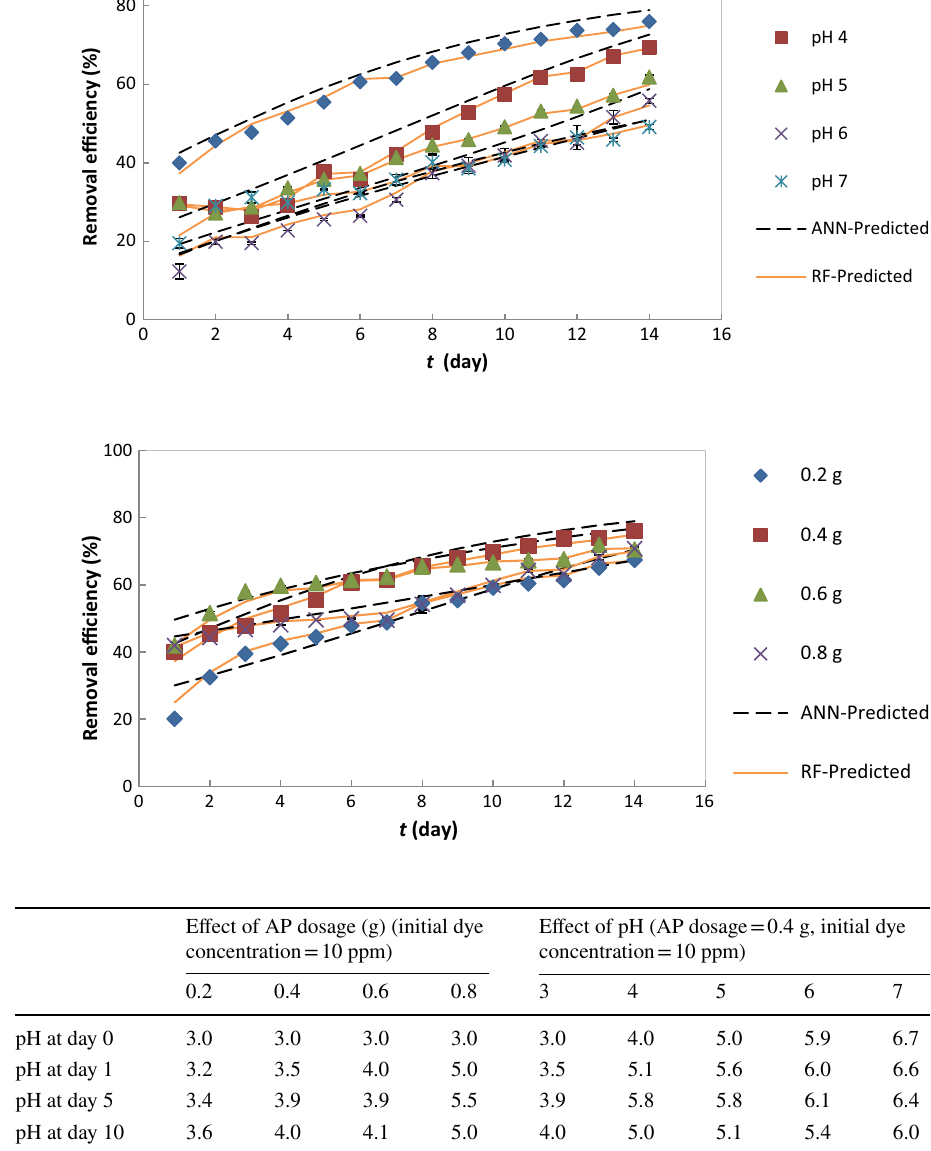
Fig. 2 Experimental data of the effect of pH on the phytoextrac- tion of RB (initial dye = 10 ppm, plant dosage 0.4 g), in com- parison with those predicted by ANN and RF models